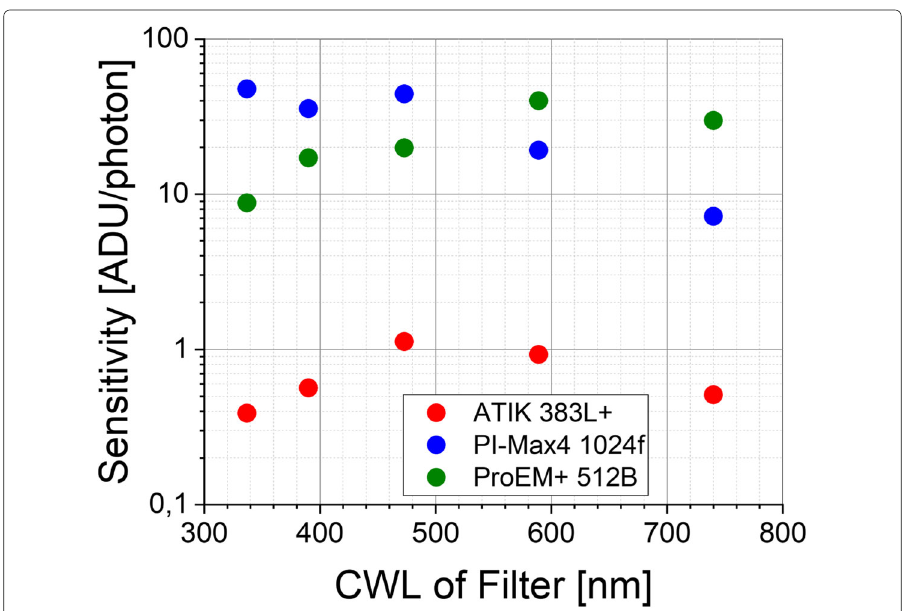
Fig. 8 The data shown in Fig. 7 are drawn on a logarithmic scale for a better comparison of the wavelength dependence of the sensitivity of the three camera systems which have been tested